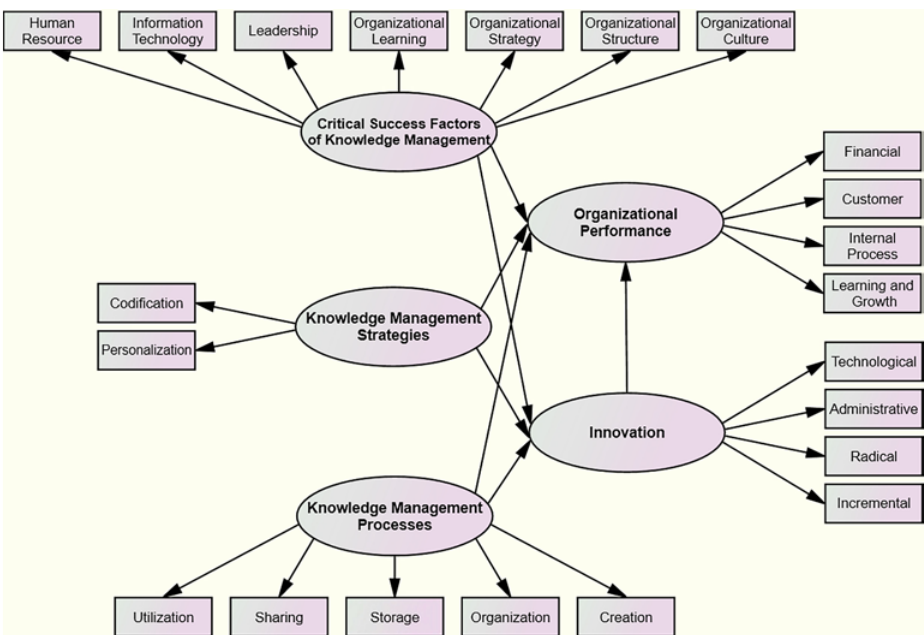
Fig. 1. Theoretical framework of the